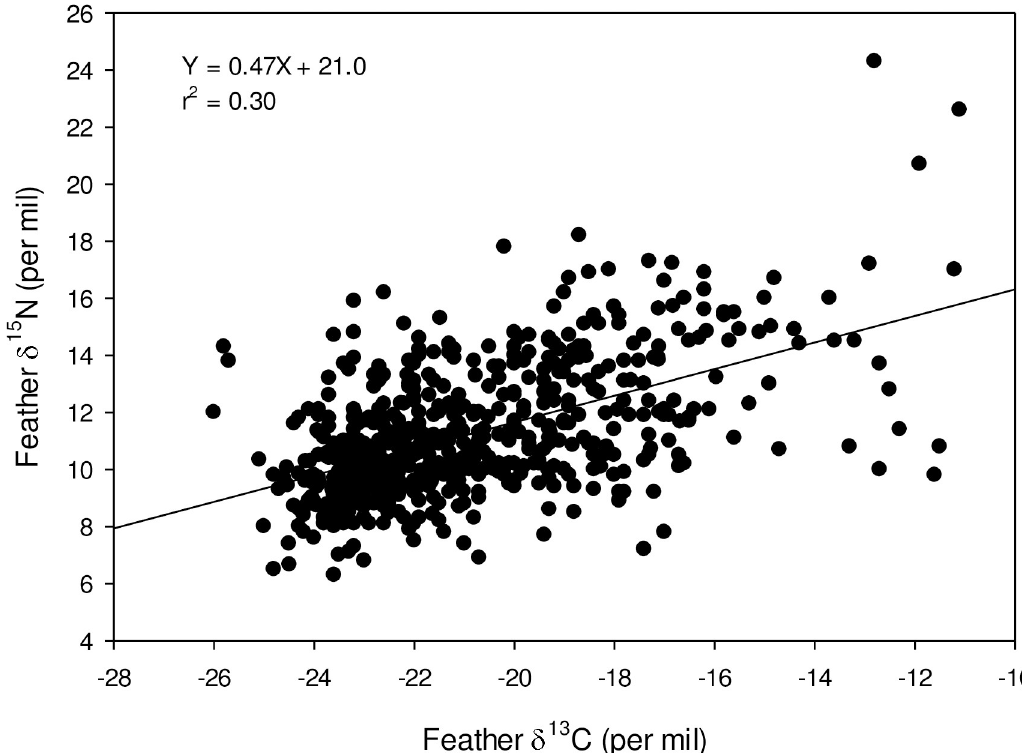
Fig 4. Relationship between feather δ 15 N and δ 13 C for 596 adult starlings collected across the Unites States.